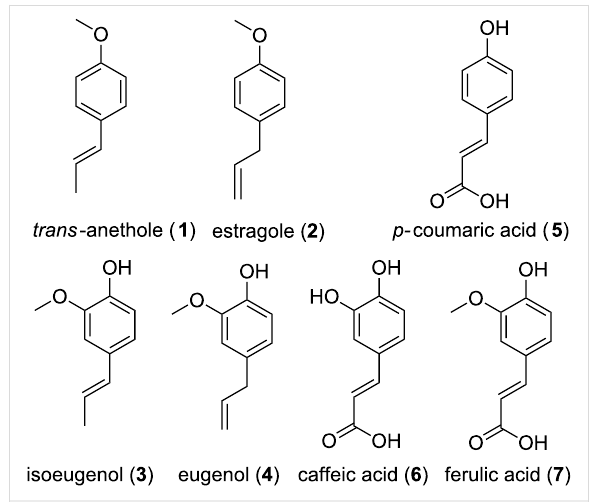
Figure 1: Chemical structure of studied phenylpropanoids